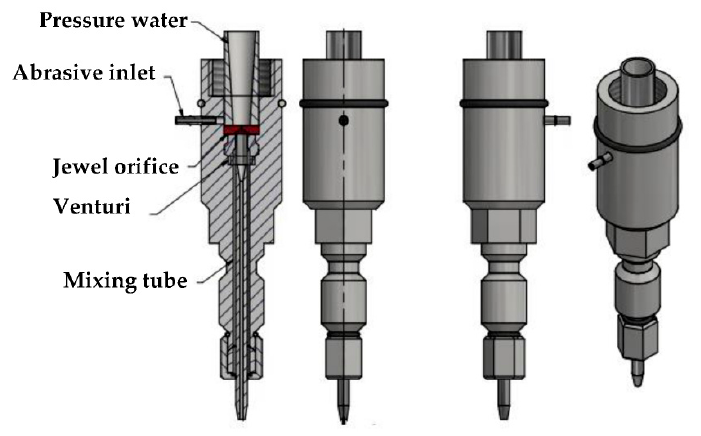
Figure 5. Nozzle system